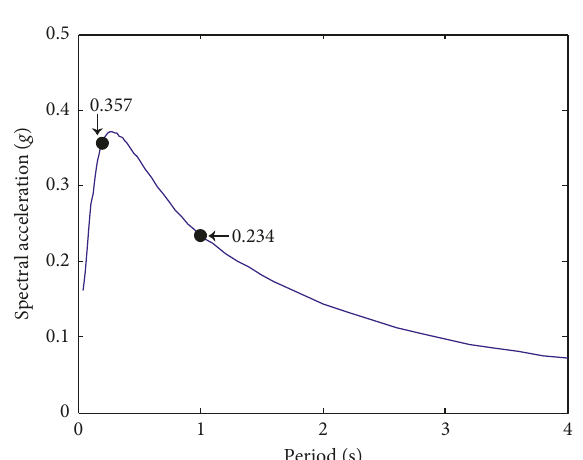
Figure 9: UHS. 1 × 10 − 4 rate of